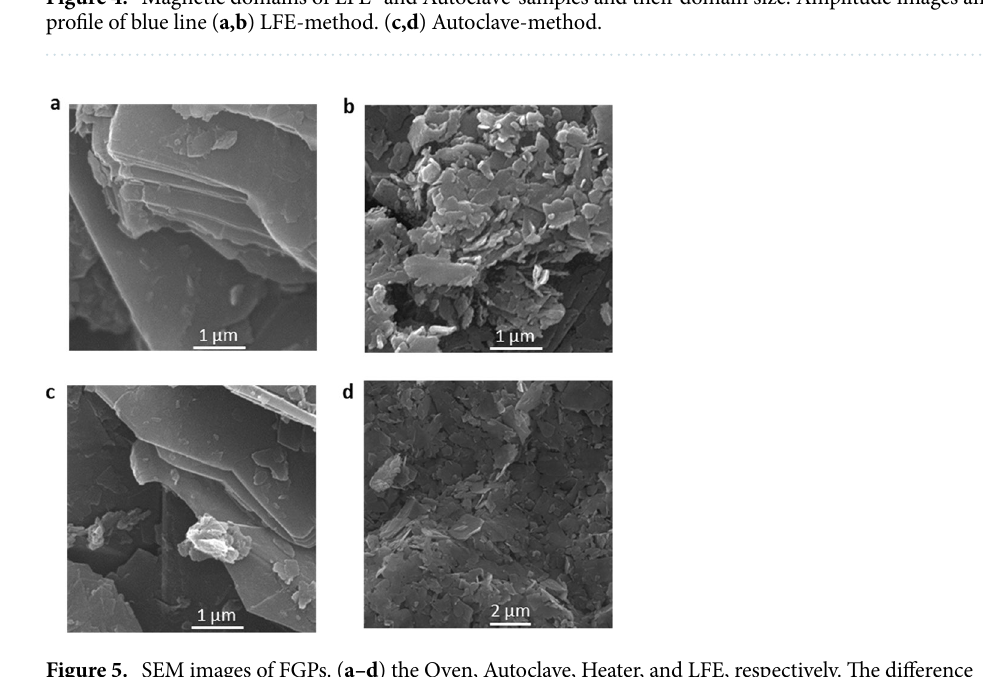
Figure 5. SEM images of FGPs. ( a–d ) the Oven, Autoclave, Heater, and LFE, respectively. The difference between stacking and aggregation process is obvious in the images. ( a,c ) Stacking. ( b,d )